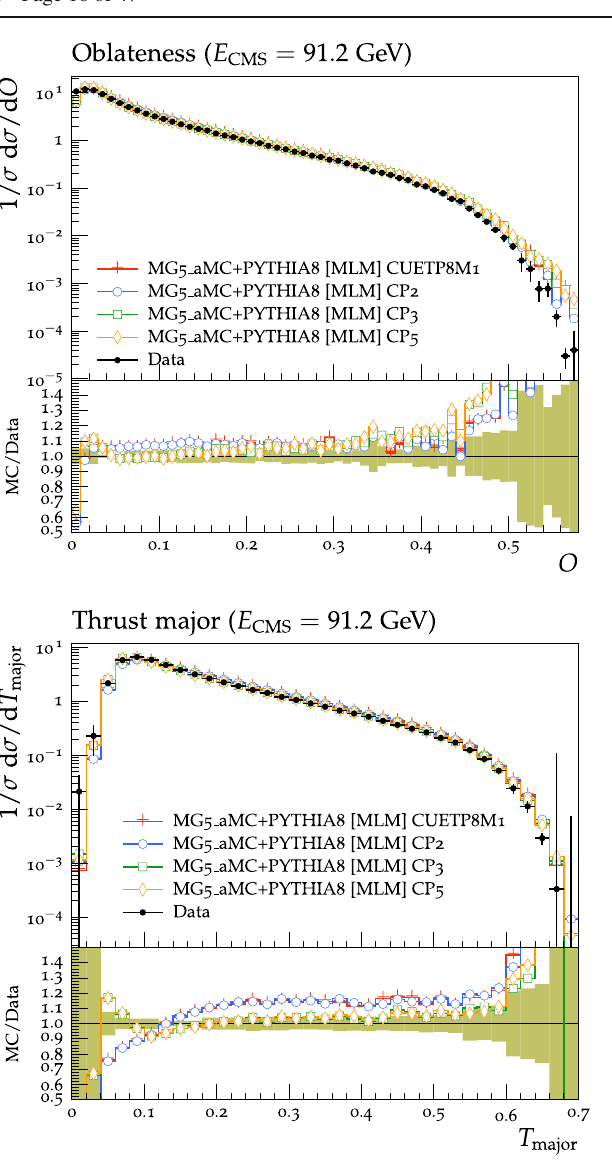
Fig. 11 The normalized cross sections as a function of event-shape the simulations to the data (MC/Data) is also shown, where the shaded band indicates the total experimental uncertainty in the data. Vertical variables, oblateness (upper left), sphericity (upper right), thrust (lower √ s = 91 . 2GeV lines drawn on the data points refer to the total uncertainty in the data. left), and thrust major (lower right) from the ALEPH Vertical lines drawn on the MC points refer to the statistical uncertainty analysis [45], compared with the predictions by mg5 _a mc + pythia 8 in the predictions. Horizontal bars indicate the associated bin with k T –MLM merging, for tunes CP2, CP3, and CP5. The ratio of